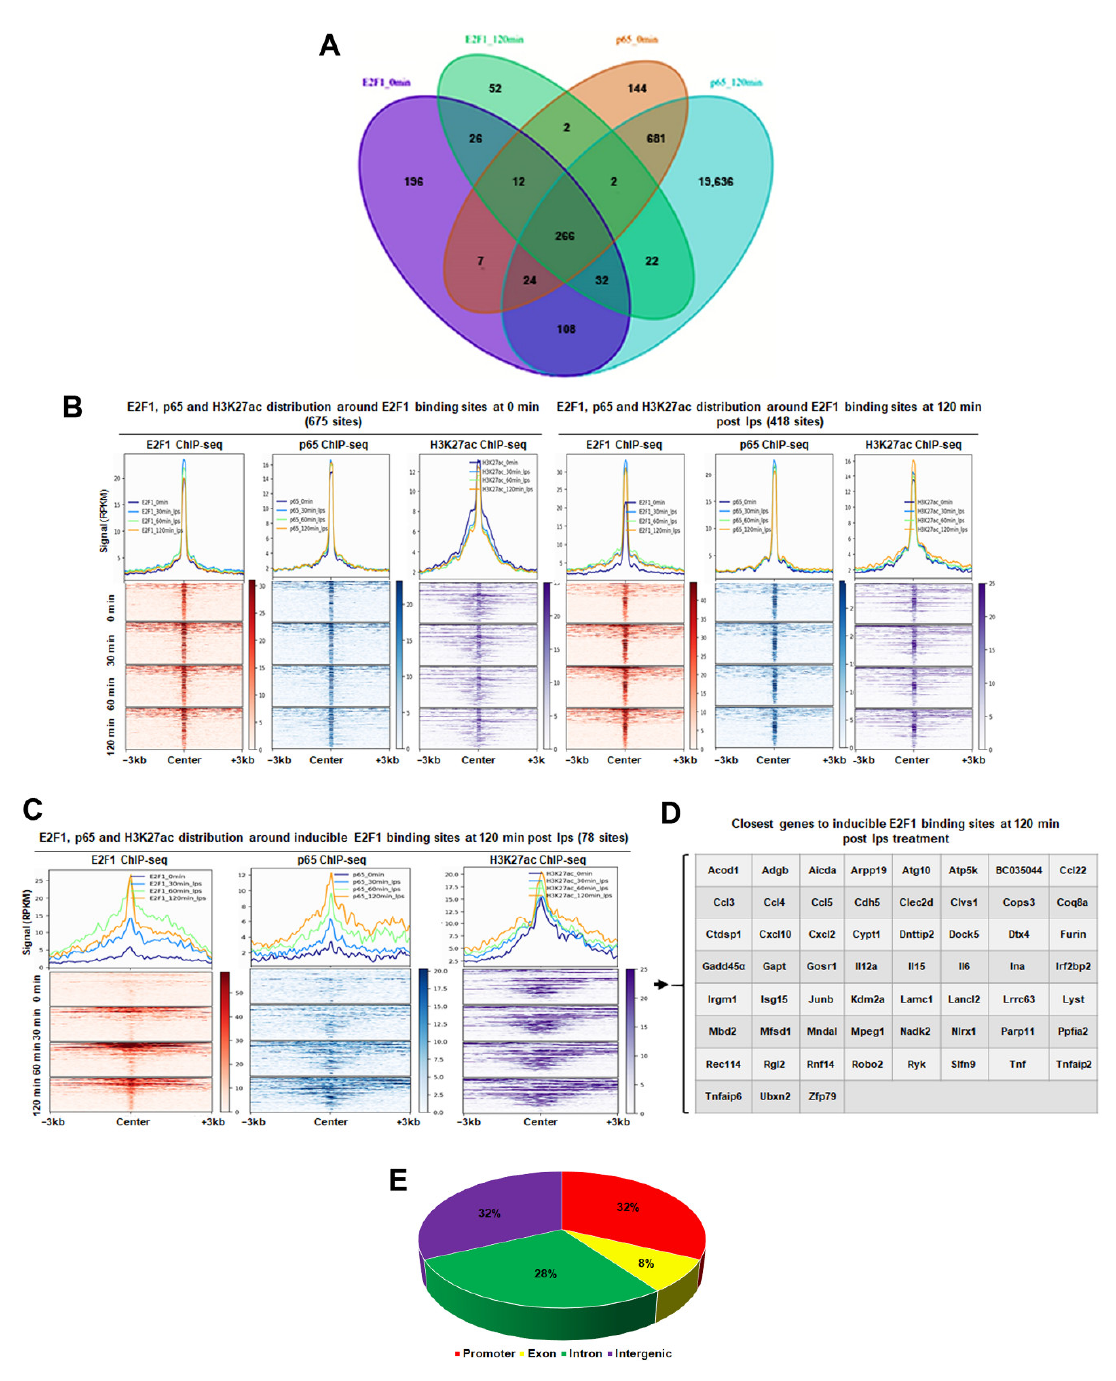
Figure 6. ( A ) Venn diagram depicting comparisons between E2F1 and p65 peaks prior and upon treatment with LPS for 120 min. ( B ) Aggregate plots ( up ) and heatmaps ( down ) depicting E2F1, p65, and H3K27ac levels around the E2F1 peaks at basal state ( left ) and 120 min after LPS treatment ( right ). ( C ) Aggregate plots ( up ) and heatmaps ( down) showing E2F1, p65, and HK327ac levels around the 78 inducible E2F1 peaks 120 min after LPS treatment. ( D ) Closest genes to E2F1 inducible peaks 120 min after LPS treatment. ( E ) The genomic distribution of E2F1 inducible peaks 120 min after LPS treatment.